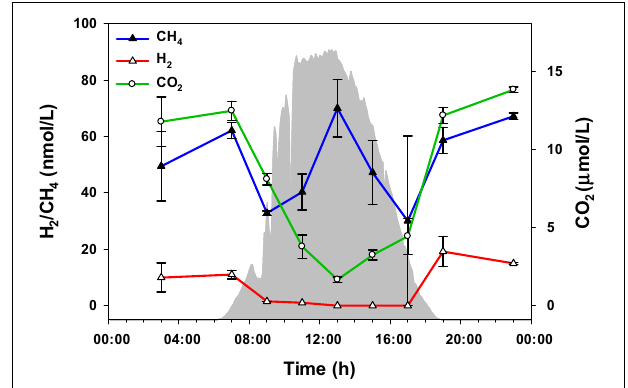
FIGURE 6 | Gaseous metabolites over the diel cycle. Solar irradiance (solid gray) and CO 2 , H 2 , and CH 4 levels in water overflowing the mat are shown. Metabolite values plotted are mean ± standard error ( n = 3